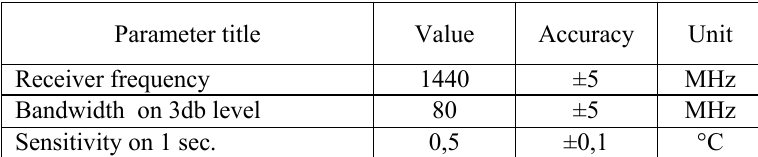
Table 1. The main parameters of the new